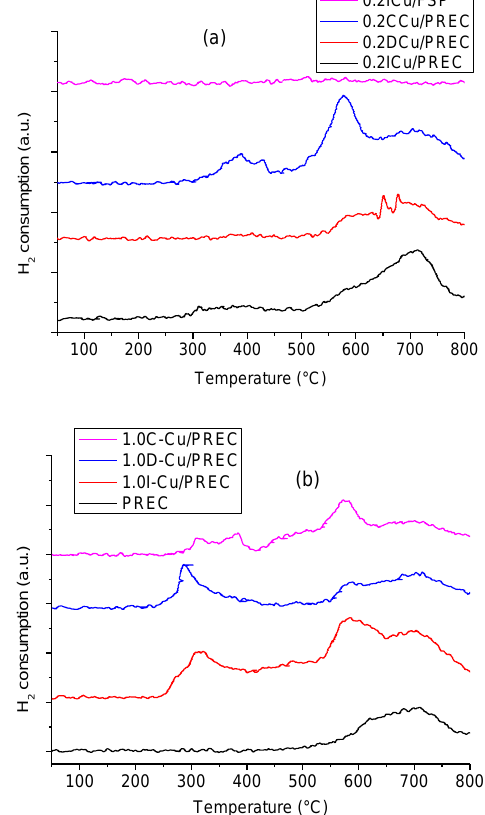
Figure 4. Temperature programmed reduction (TPR) analysis of selected samples: 0.2 wt % ( a ) and 1 wt % ( b ).